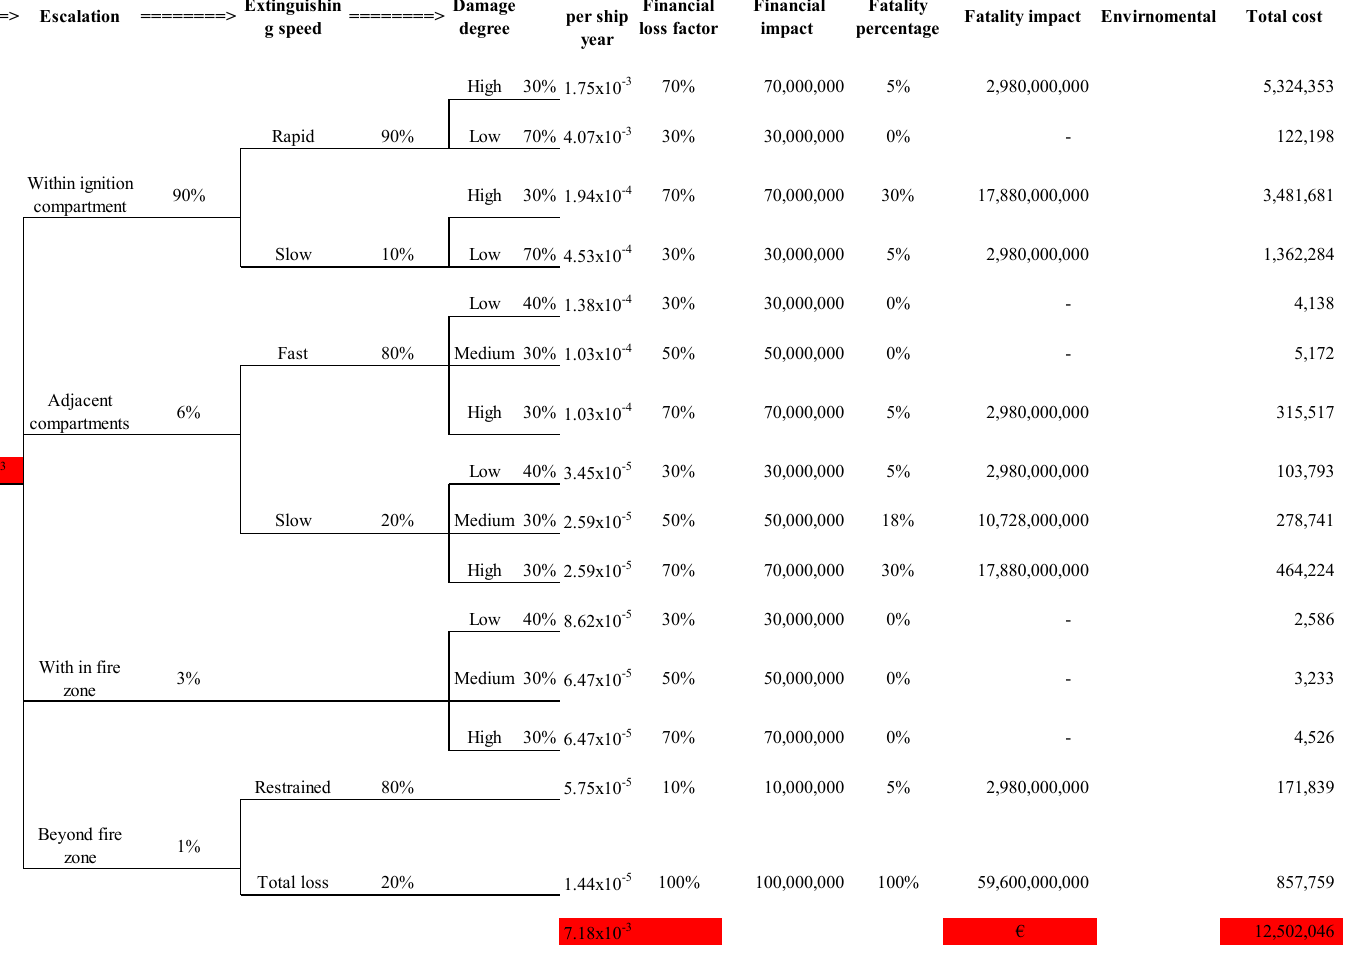
Figure 15. Event tree analysis of fire for passenger ships.